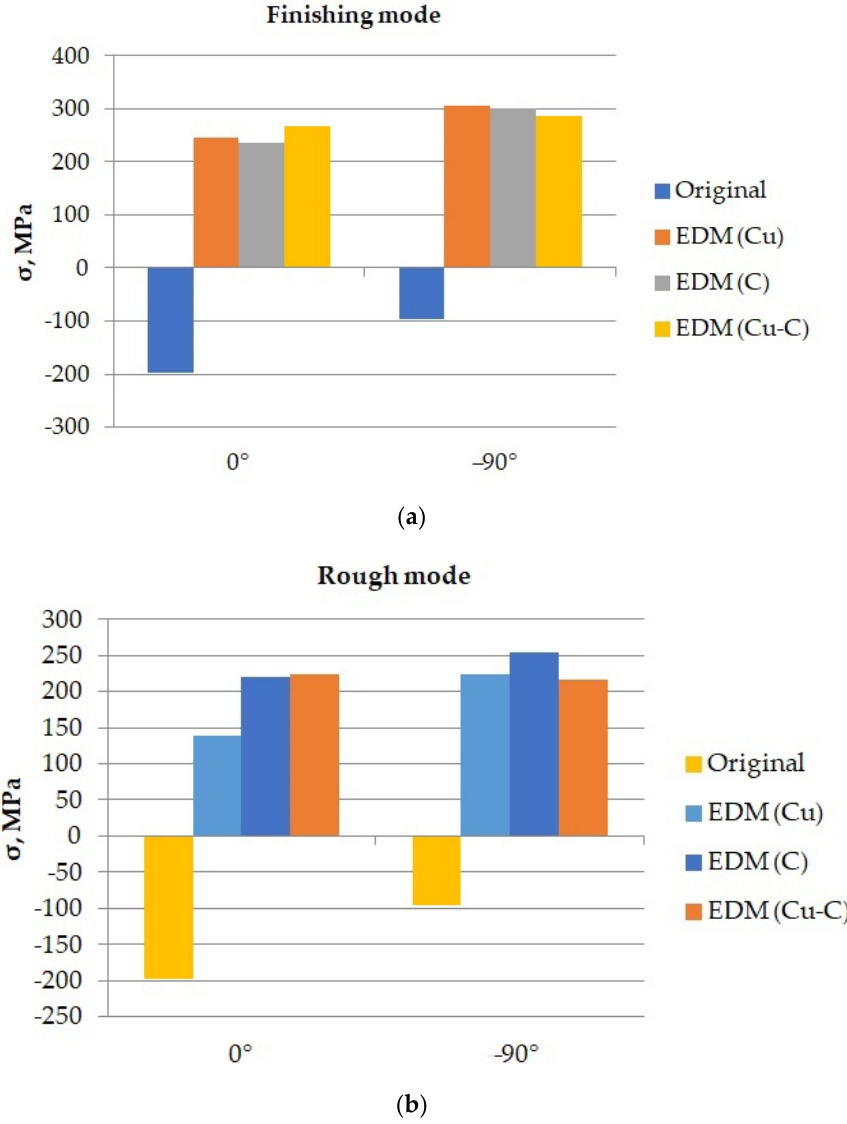
Figure 19. Histograms of changes in the residual stresses of the samples in the EDM process: ( a ) in the finishing mode; ( b ) in draft mode.